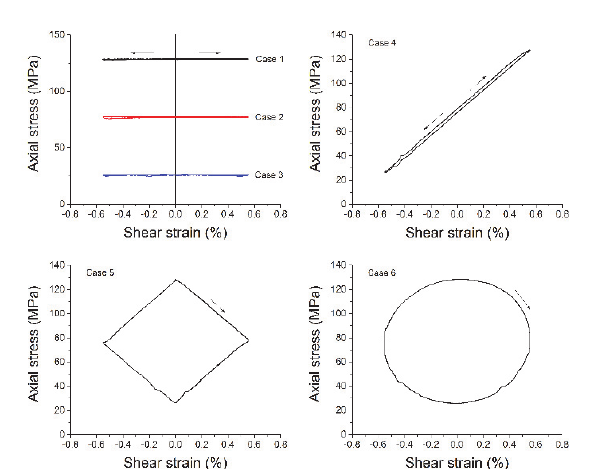
Figure 2: Loading paths in cyclic tension-torsion tests.